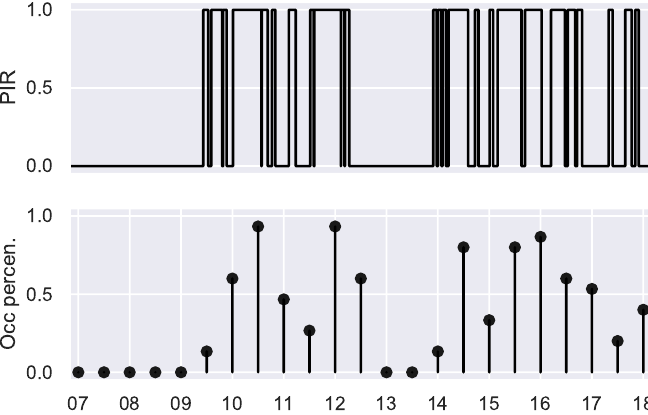
Figure 2. Modelling performed to obtain a percentage of presence from the raw PIR data for a workday. The pattern in Figure 2 corresponds to a day with a working time table from 8:30 to 17:30. It